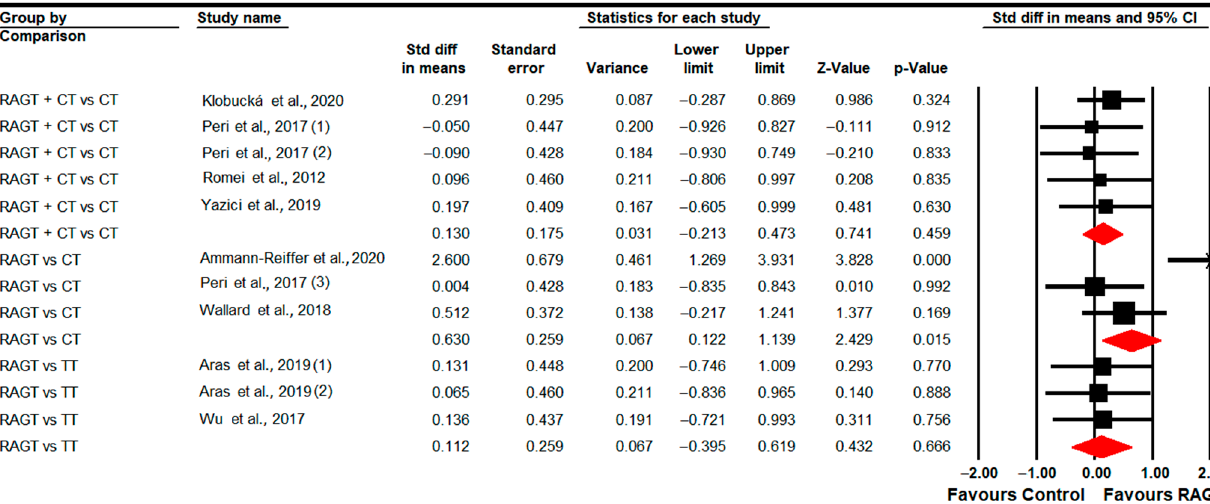
Figure 9. Forest plot of walking, running and jumping ability (Post-Intervention Assessment)